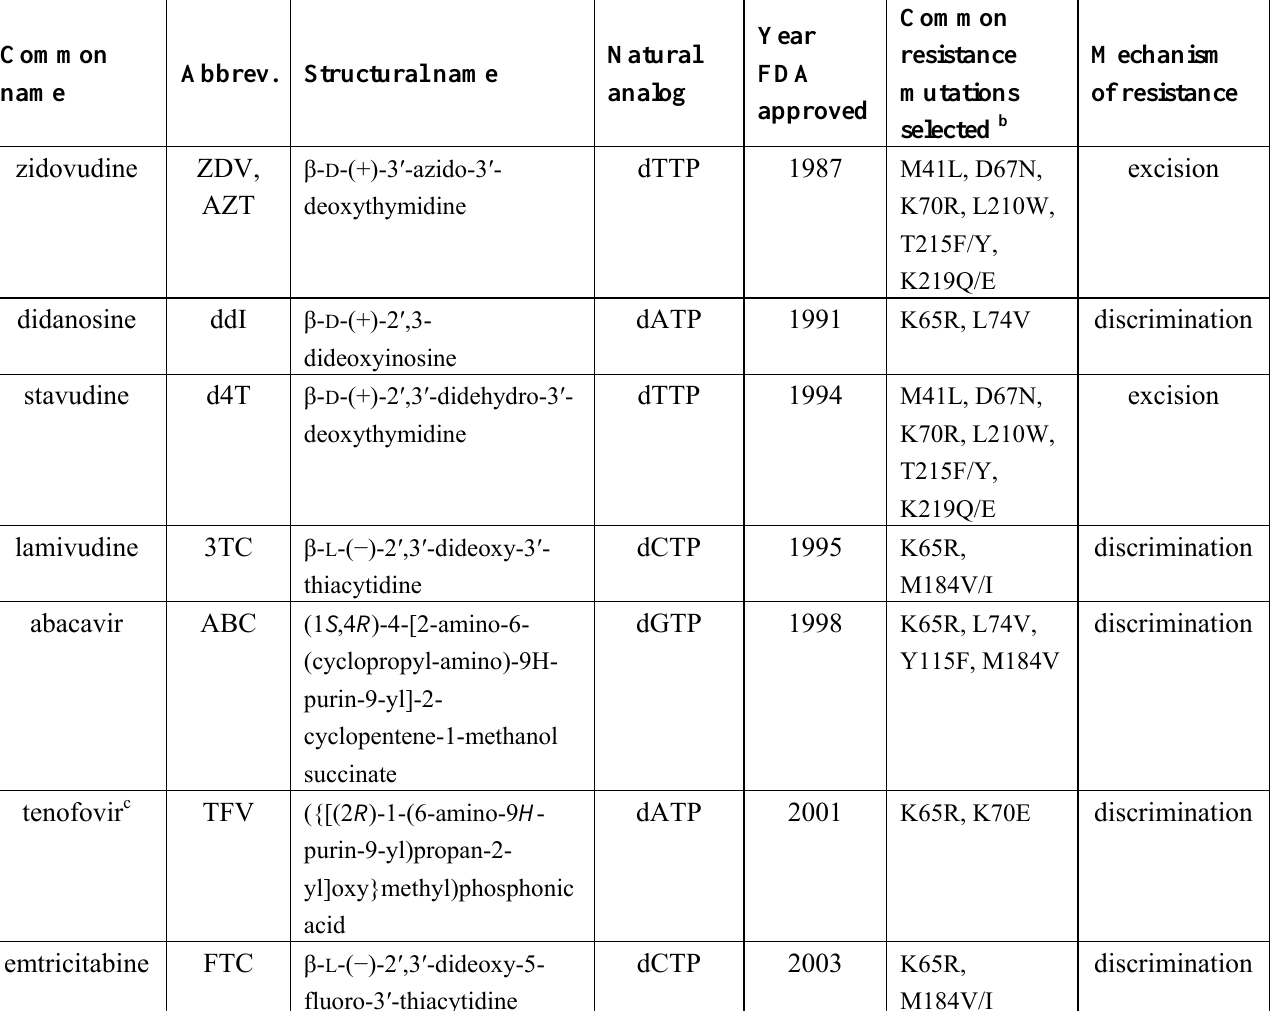
Table 1. NRTIs currently used in clinical therapy a